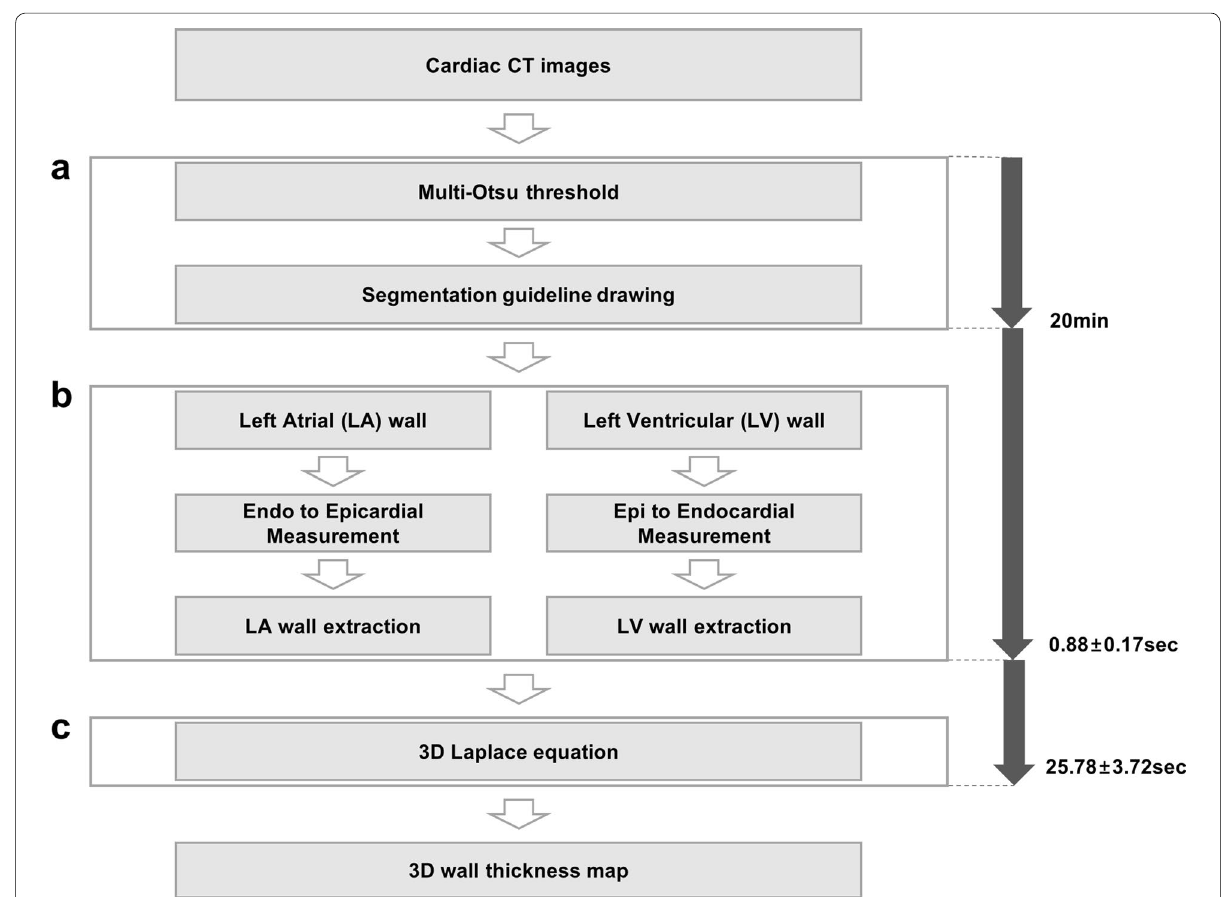
Fig. 1 Process flowchart of AMBER software. a The thresholds automatically calculated by the multi‑Otsu algorithm on the histogram of cardiac CT, and the investigator draws the guideline for the basis of the myocardial extraction. b The process of myocardial extraction to the atrium and ventricle. c Solving the Laplace